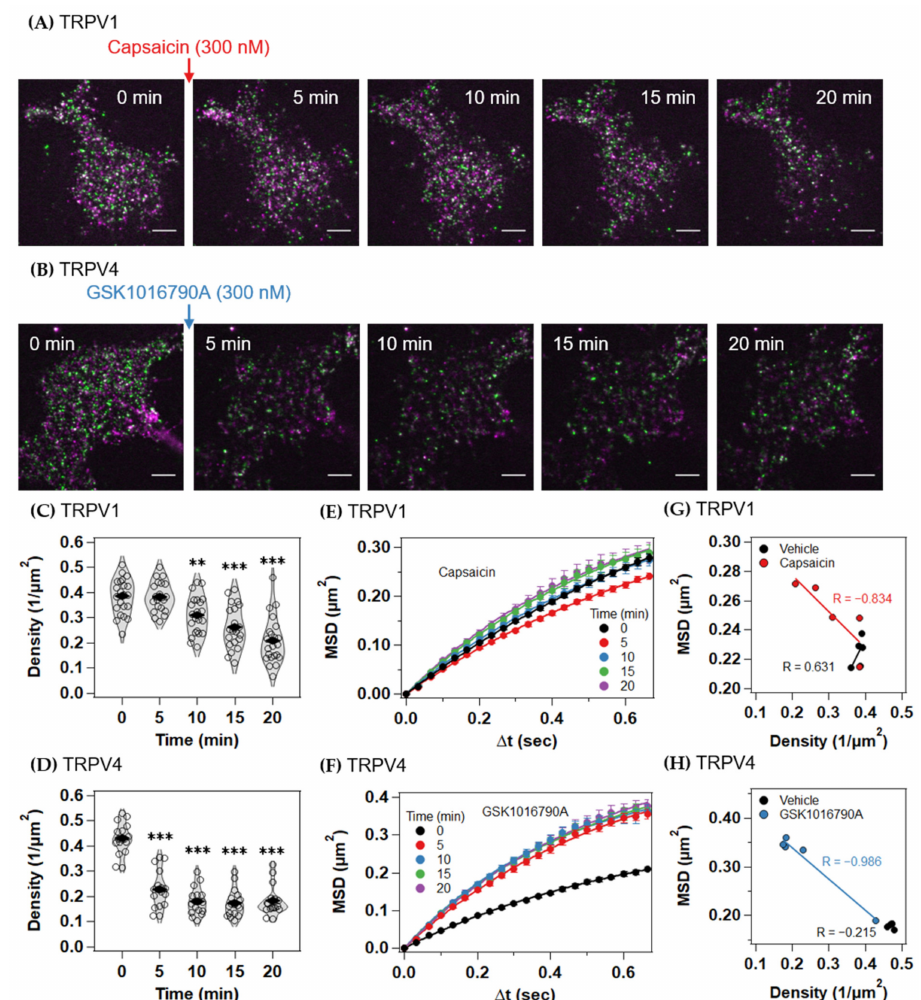
Figure 2. TIRFM image, receptor density, mean squared displacement (MSD)– ∆ t plots of TRPV1 and TRPV4 channels after activation. ( A , B ) Representative time-lapse TIRFM images of TRPV4-knockout (KO) HEK293 cell expressing JF549 (magenta)- and SF650 (green)-labeled TRPV1 after capsaicin (300 nM) stimulation ( A ); and TRPV4 after GSK1016790A (300 nM) stimulation ( B ). Scale bars, 5 µ m. ( C , D ) Density of JF549-labeled TRPV1 ( C ) and JF549-labeled TRPV4 ( D ) after agonist stimulation. ( E , F ) MSD– ∆ t plots of the trajectories under the indicated ligand conditions. JF549-labeled TRPV1 ( E ), JF549-labeled TRPV4 ( F ). Data are means ± SEM of 17–22 cells. ** p < 0.01, *** p < 0.001 (one-way ANOVA followed by Dunnett’s multiple-comparisons test versus basal level). ( G , H ) Correlation between receptor density and time-averaged MSD at each time point for JF549-labeled TRPV1 ( G ) and JF549-labeled TRPV4 ( H ). Each circle represents a time point. Lines are regression lines, and R is Pearson’s correlation